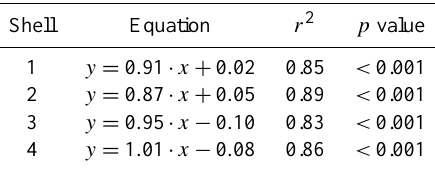
Table 2. Results of the linear regression between measured and pre- dicted δ 18 O values in the four E. directus shells. x is the predicted δ 18 O; y the measured δ 18